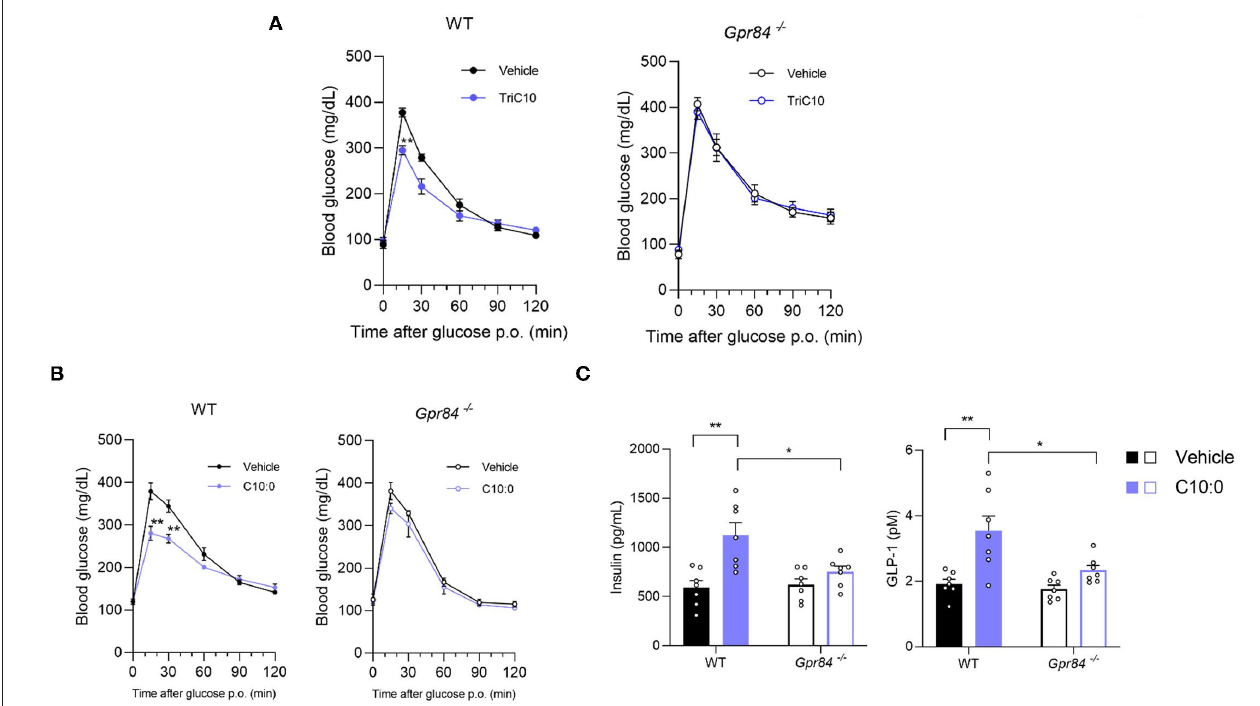
FIGURE 5 | Decanoate (C10:0) enhanced glucose tolerance via GPR84-mediated GLP-1 secretion in mice. (A) Oral glucose tolerance test (OGTT) was performed at 1h post-decanoate triglyceride administration (2.4 g/kg body weight) (left, WT mice; n = 7, 6; right, Gpr84 − / − mice; n = 5). (B) OGTT was performed at 2h post-decanoate administration (1 g/kg body weight) (left, WT; right, Gpr84 − / − mice; n = 7). (C) The plasma levels of insulin (left) and GLP-1 (right) at 2.5h after the oral administration of decanoate ( n = 7). ** P < 0.01, * P < 0.05 (Tukey-Kramer test). All data are presented as the means ± standard error of mean (SEM).